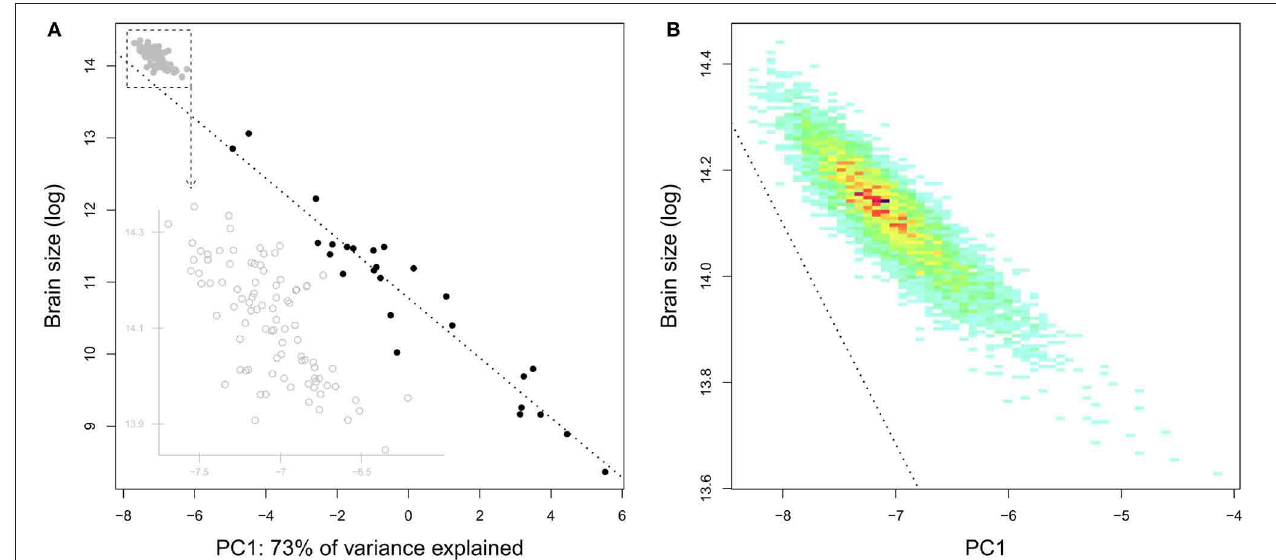
FIGURE 9 | (A) Brain size as a function of the species position on the first component of a principal component analysis of simians’ brain structure proportions (the structures included are medulla, cerebellum, mesencephalon, diencephalon, striatum, septum, olfactory cortex, hippocampus, subicular cortex, neocortex). The position of the human individuals (gray) has been predicted by the PCA done with simian species